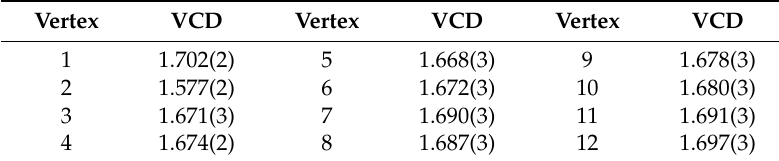
Table 3. Vertex − centroid distances (/Å) in [1-{CpRu(PMe 2 Ph) 2 }-2-Me- closo -1,2-C 2 B 10 H 10 ] 1 . Vertex VCD Vertex VCD Vertex VCD